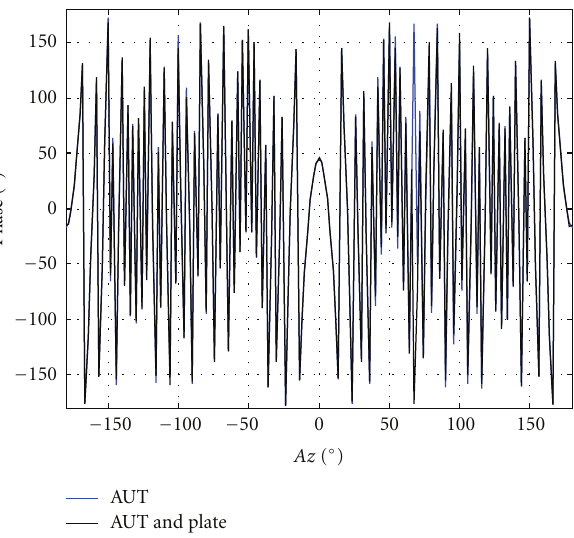
Figure 7: Far-field phase pattern of OEWG with and without plate. AUT o ff set =